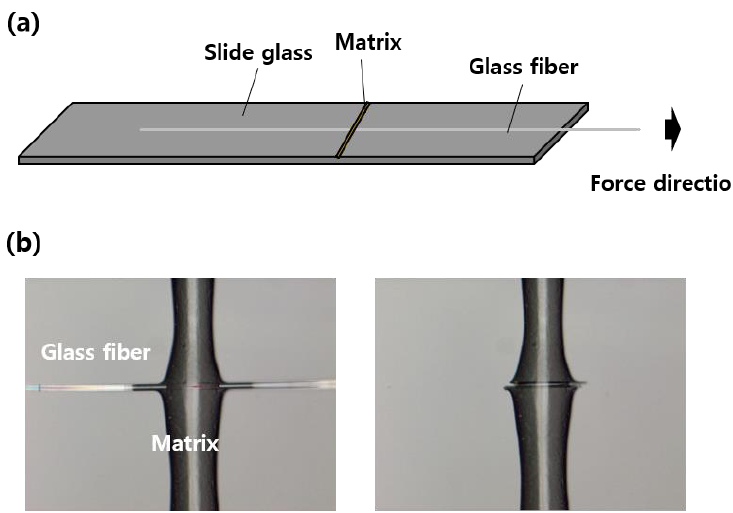
Figure 5. Single-fiber pullout test: ( a ) specimen composition and ( b ) OM images before and after the experiment.